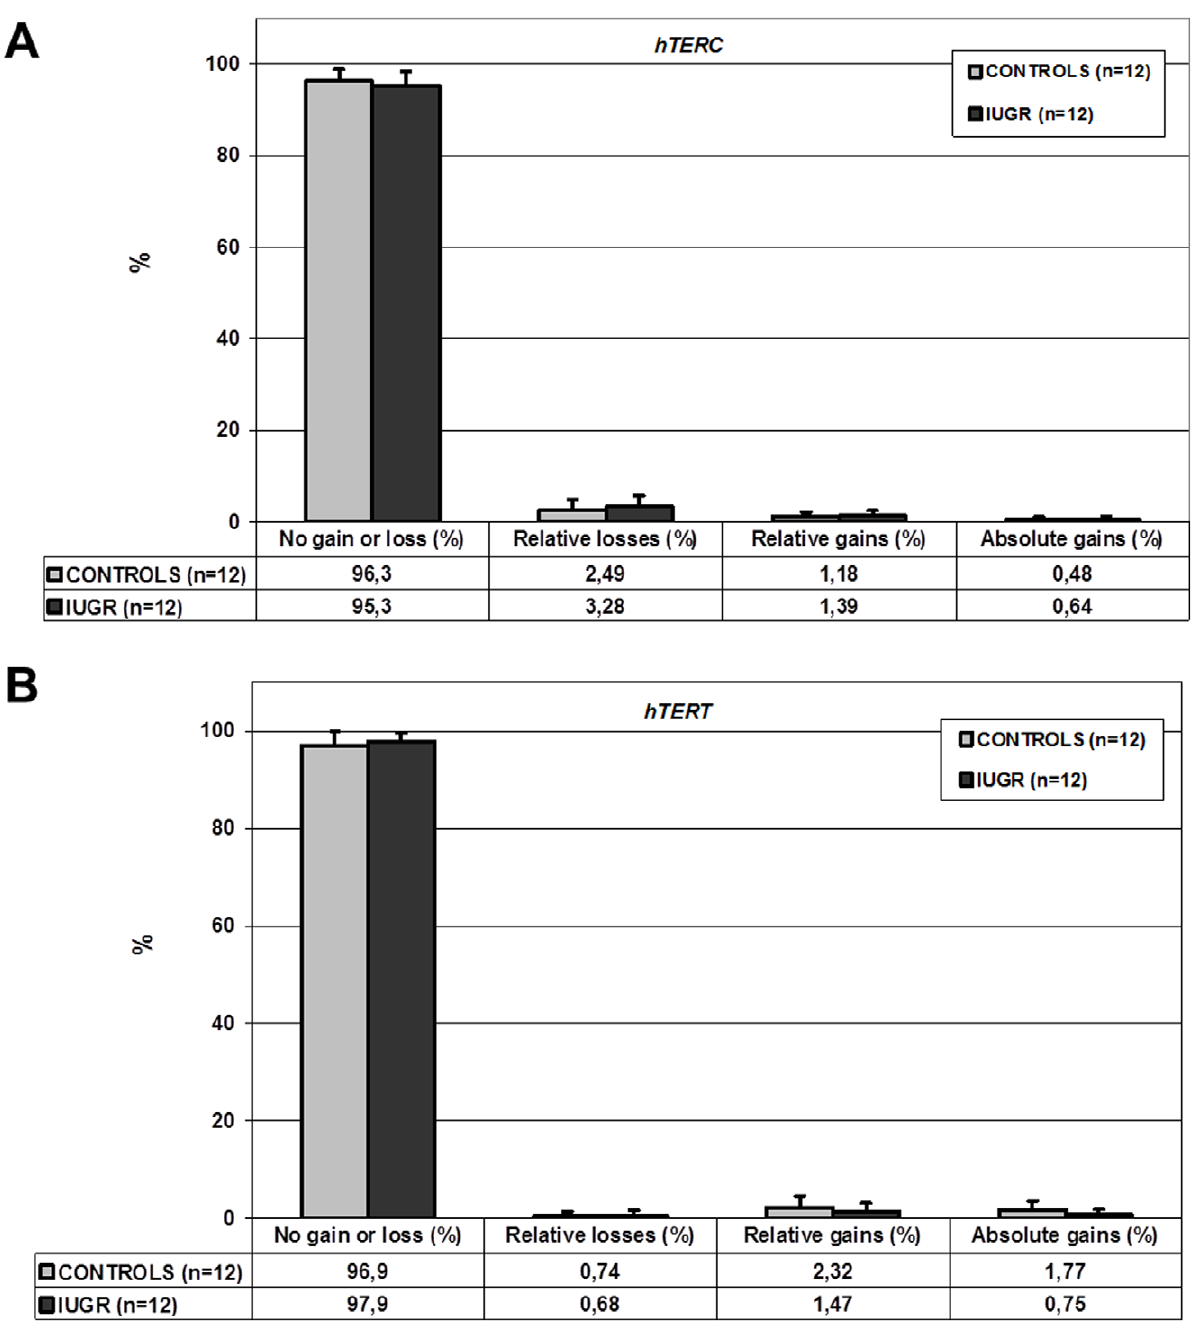
Figure 3. Copy number evaluation by Fluorescence InSitu Hybridization (FISH) of the loci carrying hTERC and hTERT in late chorionic villus samplings. A. Percentage of interphase nuclei displaying no gain or loss, relative losses, relative gains, and absolute gains of hTERC locus with the FISH technique 6 standard deviation (%) for 12 controls (light grey histograms) and 12 cases with intrauterine growth restriction (IUGR) (dark grey histograms) randomly selected ( p =non-significant (NS), Student’s t-test). B. Percentage of interphase nuclei displaying no gain or loss, relative losses, relative gains, and absolute gains of hTERT locus with the FISH technique 6 standard deviation (%) for 12 controls (light grey histograms) and 12 cases with IUGR (dark grey histograms) randomly selected ( p =NS, Student’s